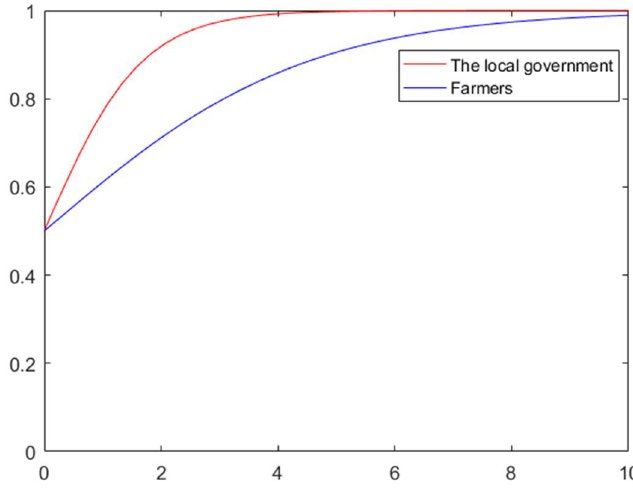
Figure 7. Simulation results at the second stage ( ∆ S 2 = 1.5 ) .